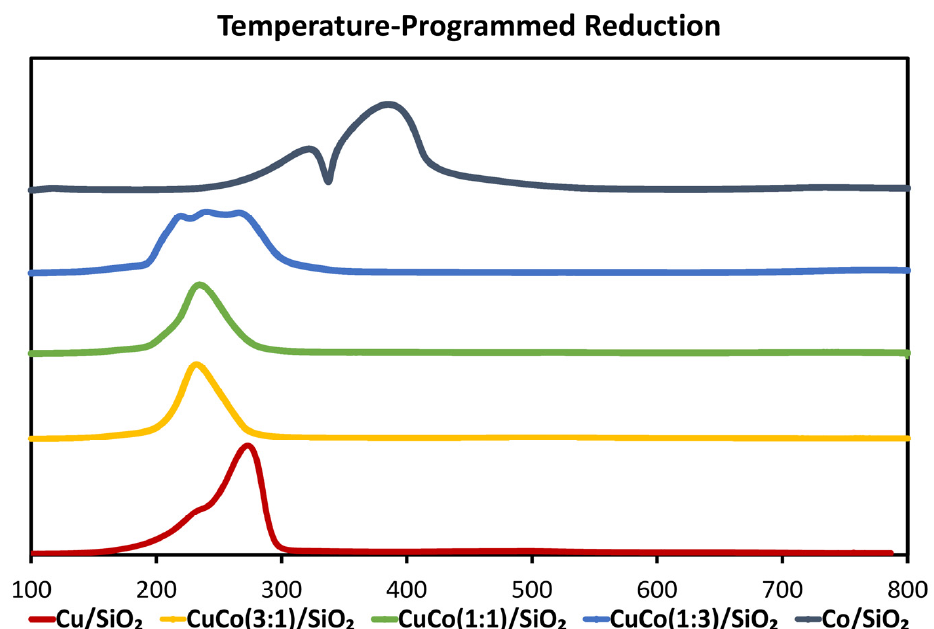
Figure 1. Temperature-programmed reduction of Cu, Co and CuCo catalysts.